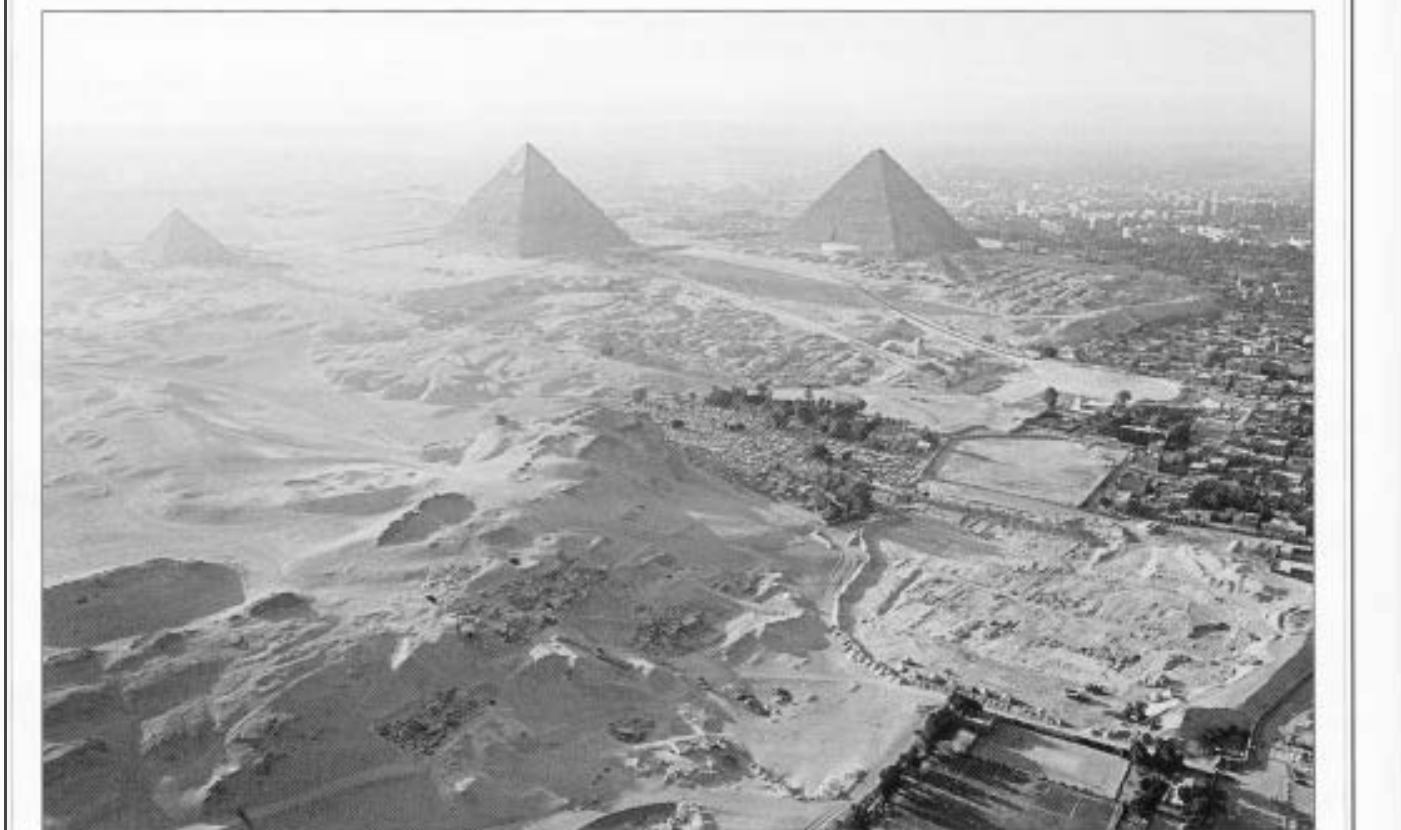
Fi gure 1 Aerial view of the Giza plateau, showing the three pyramids of(from right to left) the pharaohs Khufu, Khafre and Menkaure, the Sphinx, the site of the pyramid builders' settlement (right foreground) and their cemetery (left